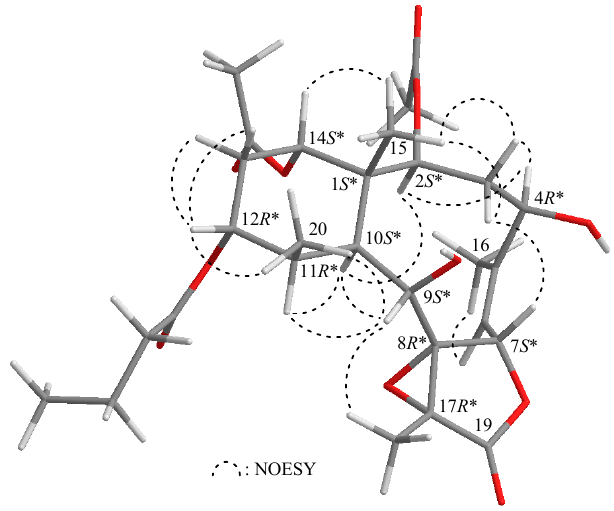
Figure 3. Selected protons with key NOESY correlations of 4 .